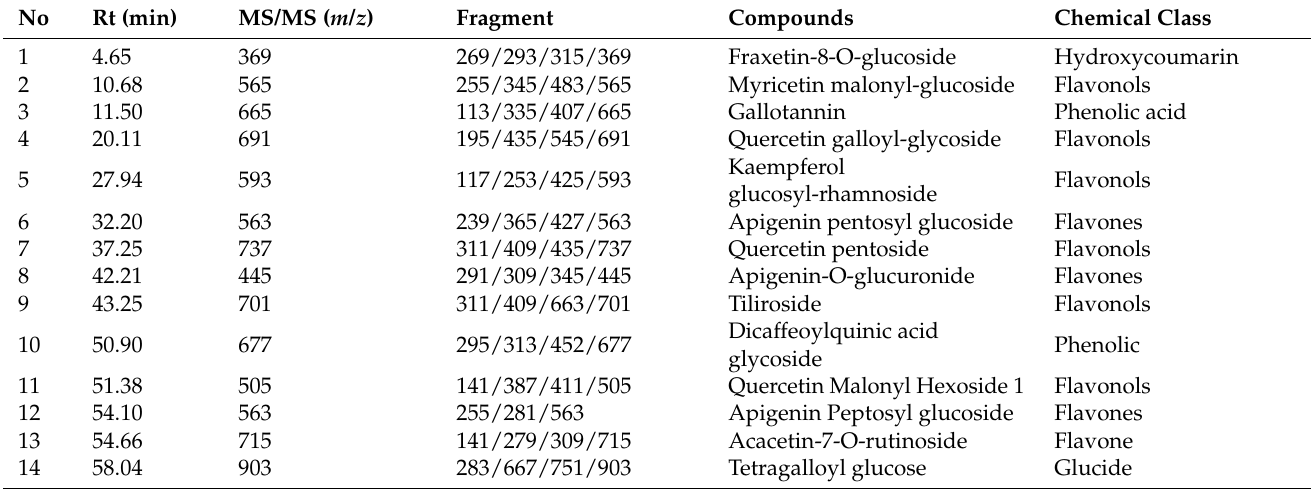
Table 3. Identification of main phenolic compounds of J. regia kernel extracts using HPLC-DAD-ESI- MS/MS.